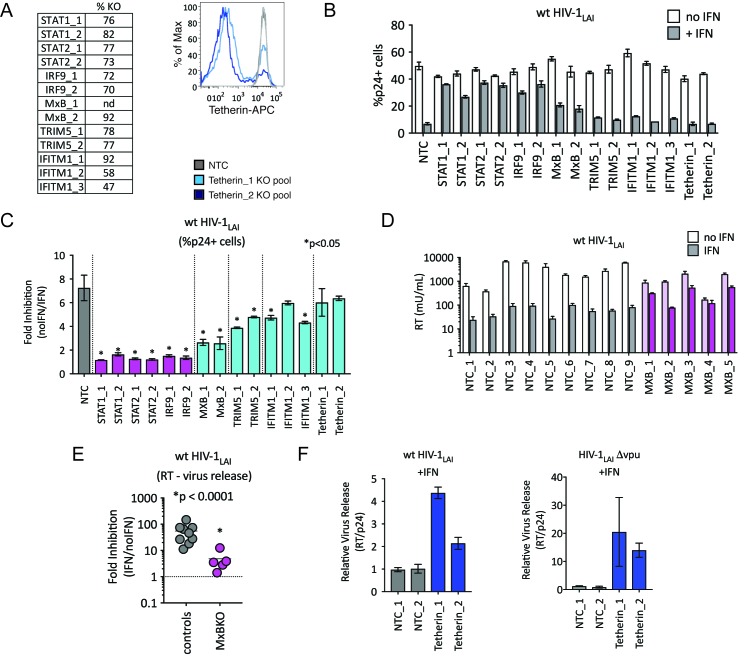
TRIM5alpha, IFITM1 and Tetherin are additional ISGs that contribute to the IFN block.(A) KO efficiencies in lentiCRISPRv2-edited THP-1 cells as determined by ICE analysis (left) or flow cytometry (right – pretreated with 1000 U/mL uIFN). (B) THP-1 cell pools edited for gene targets of interest were created by transducing wild type THP-1 cells with lentiCRISPRv2 sgRNA constructs (two different sgRNAs - for STAT1, STAT2, IRF9, MxB, TRIM5alpha and Tetherin, and three for IFITM1), selected for 2 weeks to allow gene knockout (see Figure 4—source data 1Supplemental file 1 for analysis of gene knockout efficiency) and infected with HIV-1LAI with and without IFNα pretreatment in triplicate (white bars = no IFNα, gray bars =+IFNα). The percentage of cells expressing HIV p24gag was assayed 2 days post-infection by intracellular staining and flow cytometry. NTC n = 9. MxB_2 n = 6. All other pools n = 3. (C) The Fold Inhibition (%p24 +cells without IFN/%p24 +cells with IFNα) is shown for each KO pool. Control (NTC) = gray; IFN pathway genes = magenta. MxB, TRIM5alpha, IFITM1 and Tetherin = Cyan. Cells pools with significantly reduced Fold Inhibition as compared to the NTC pools *p < 0.05 (unpaired t test). (D) Virus release from the clonal NTC (white/gray) or MxB-KO clones (pink) from Figure 3 as measured with a viral RT assay at 3 days post-infection with HIV-1LAI with and without IFNα (light bars = no IFN; dark bars = IFNα). (E) The Fold Inhibition (RT mU/mL without IFN/RT mU/mL with IFNα) calculated for each clonal line. Controls = gray; MxB-KO = magenta. Dotted line: Fold Inhibition of 1 = no IFN inhibition. (F) THP-1 cell pools (NTC_1 and NTC_2 = gray; Tetherin-KO pools = blue) created by transduction with lentiCRISPRv2 lentiviral vectors were infected in triplicate with Vpu-deficient HIV (HIV-1LAIΔvpu) or wild type HIV (wt HIV-1LAI). The HIVLAIΔvpu contains a frameshift mutation in Vpu upstream of the env open reading frame. IFNα was added 16 hr post-infection and T-20 fusion inhibitor was added 24 hr post-infection. The amount of reverse transcriptase (RT) activity released into the supernatant was then normalized to the percentage of p24 +cells in order to directly quantify virus release per infected cell in the presence of IFN (RT mU/mL/%p24 +cells in culture).10.7554/eLife.39823.016Figure 4—source data 1.ICE KO Editing Analysis.name. r^2. ICE KO score.